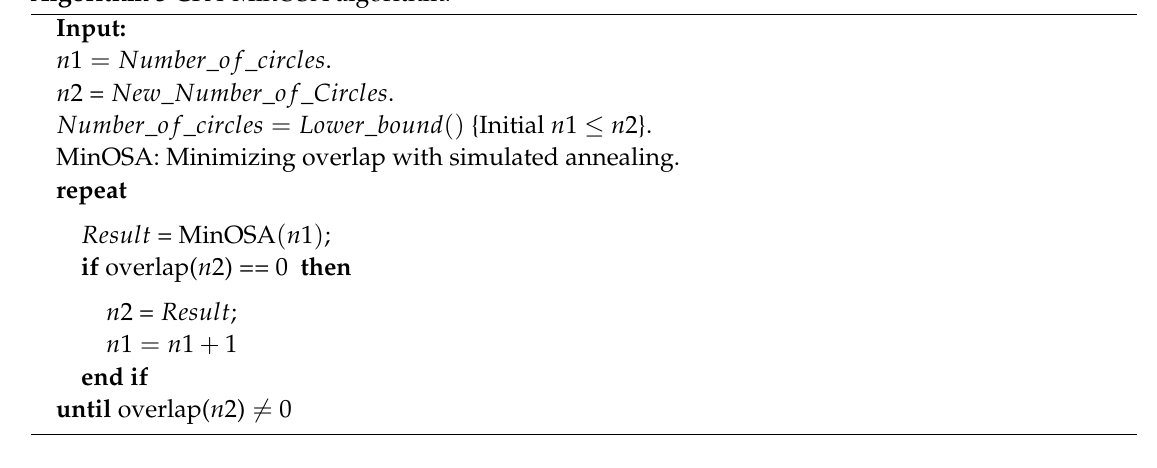
Algorithm 3 CPA-MinOSA algorithm.